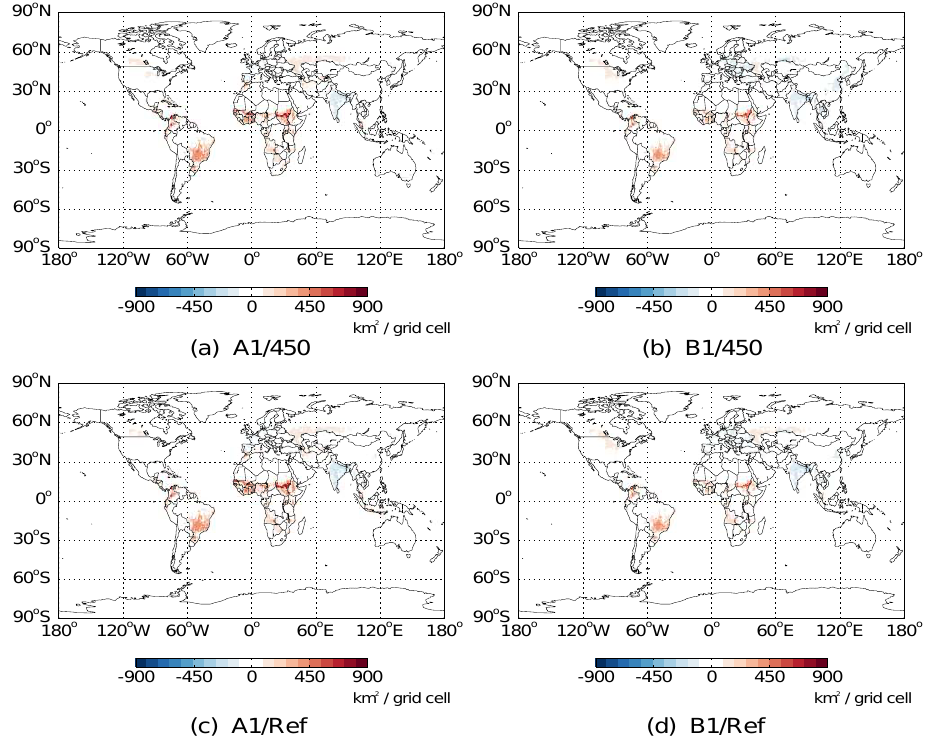
Fig. 3. Median of the spatial distribution of changes in cropland area (km 2 gridcell − 1 ) for the ensemble of A1 and B1 LUC scenarios estimated by PLUM, including the 450 and Reference biofuel usage scenarios ( n = 1000) in 2030. Country scale changes are downscaled to a 0 . 5 ◦ × 0 . 5 ◦ grid using a method detailed in the main